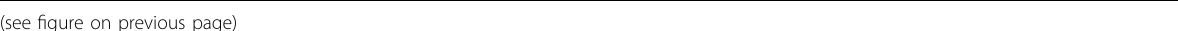
Fig. 6 ERK is responsible for the phosphorylation of GRHL1 at Ser76. A 293 T cells were transfected with control plasmid and His-GRHL1 plasmid. After serum-free treatment for 12 h and 12 h of stimulation with EGF (100 ng/ml), cells were lysed for immunoprecipitation using an anti-His antibody and blotted with indicated antibodies. B 293 T cells were transfected with His-GRHL1. After serum-free treatment for 12 h and 12 h of stimulation with EGF (100ng/ml), cells were lysed for immunoprecipitation using anti-ERK1/2 antibody and control rabbit IgG and blotted with indicated antibodies. C A549 cells were transiently transfected with control plasmid, His-GRHL1 plasmid and His-GRHL1(T208A) plasmid respectively. Forty-eight hours later, the cells were lysed. Protein expression was assessed by western blotting using the indicated antibodies. D A549 cells were transfected with His-GRHL1(T208A) plasmid, after serum-free treatment for 12 h and 24 h of stimulation with EGF (100 ng/ml), the nuclear and cytoplasmic fractions were separated and the location of GRHL1 was detected by western blot. E A549 cells were transiently transfected with control plasmid and six mutants (mut1: S25S28S35A, mut2: S76S77A, mut3: S95A, mut4: S442A, mut5: S493S501A, mut6: S539A) plasmids respectively. Forty- eight hours later, the cells were lysed. Protein expression was assessed by western blotting using the indicated antibodies. F A549 cells were transfected with His-GRHL1 plasmid and His-GRHL1(S76S77A) plasmid, after serum-free treatment for 12 h and 24 h of stimulation with EGF (100 ng/ ml), the nuclear and cytoplasmic fractions were separated and the GRHL1 in nuclear was detected by western blot. G A549 cells were transiently transfected with control plasmid, His-GRHL1(S76A), and His-GRHL1(S77A) plasmids respectively. Forty-eight hours later, the cells were lysed. Protein expression was assessed by western blotting using the indicated antibodies. H A549 cells were transfected with His-GRHL1 plasmid and His-GRHL1 (S76A) plasmid, after serum-free treatment for 12 h and 24 h of stimulation with EGF (100 ng/ml), the nuclear and cytoplasmic fractions were separated and the location of GRHL1 was detected by western blot. I – J A549 and H1299 cells were transfected with His-GRHL1 plasmid and His- GRHL1(S76A) plasmid. After serum-free treatment for 12 h, EGF (100 ng/ml) was added. After 12 h. The location of GRHL1 was detected by immuno fl uorescence staining. Cells were stained with anti-GRHL1 (left panel, red) and DAPI (middle panel, blue). The merged images are shown in the right panel. Scale bar = 25 μm, magni fi cation: